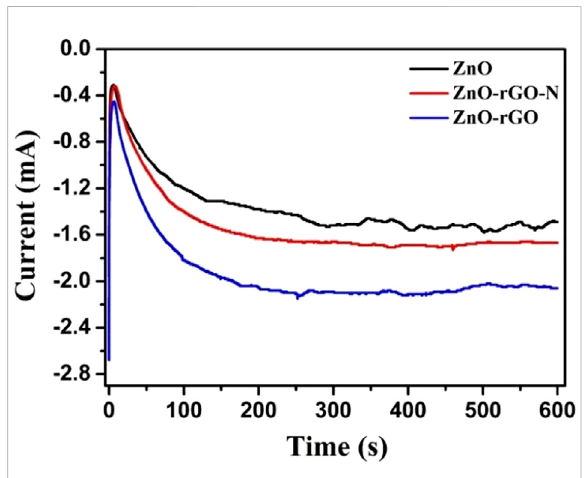
FIGURE 1 CA curves for the electrodeposition of ZnO, ZnO-rGO-N, and ZnO-rGO at a potential of -1.1